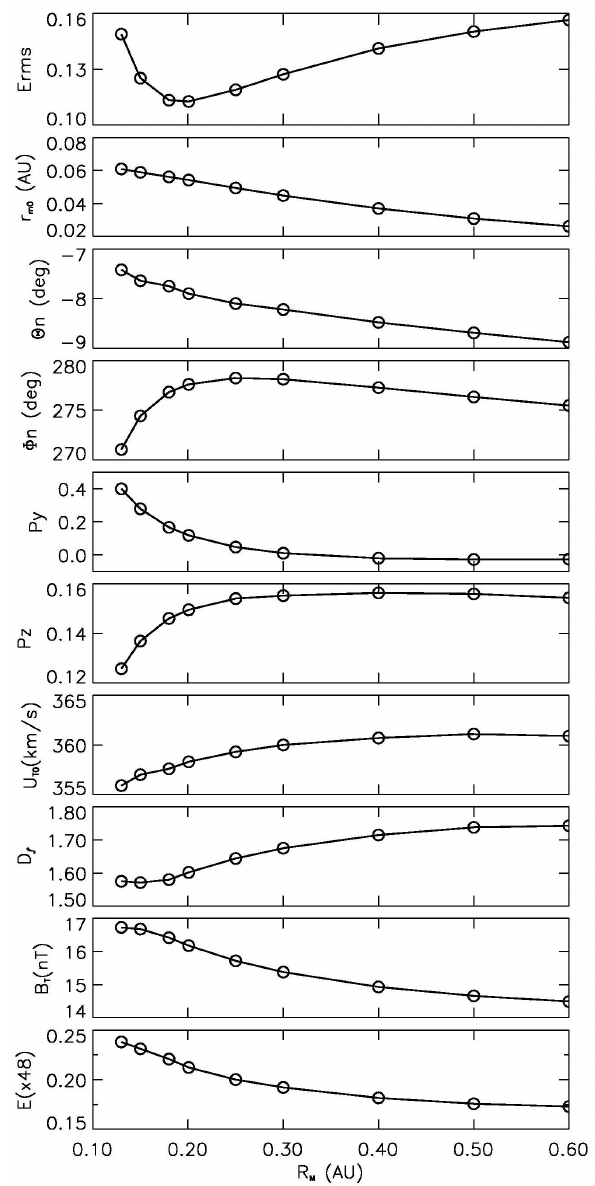
Fig. C1. Dependence of the torus parameters obtained for the mag- netic cloud of 4 February 1998 (Event No. 6), on the change of the major radius R M